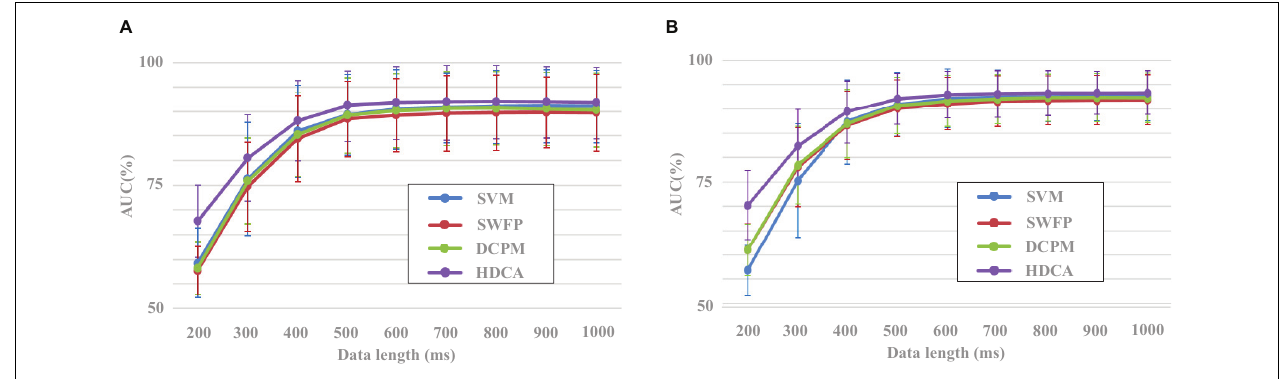
FIGURE 6 | Performance of different classification methods with different data lengths. (A) Block 1 for training and block 2 for testing. (B) Result of 10-fold cross-validation using both blocks 1 and 2.